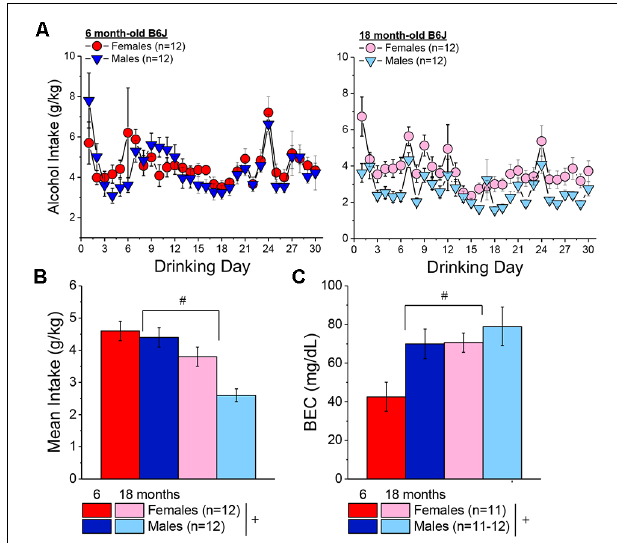
FIGURE 8 | Binge drinking during later maturity (6 months of age) vs. old-age (18 months of age) in isogenic C57BL/6J mice. (A) Comparison of the time-courses of binge drinking between the 6-month-old (left) and 18-month-old (right) mice in Experiment 3. (B) On average, females in Experiment 3 consumed more alcohol than males, and 6-month-old mice consumed more alcohol than 18-month-old mice, over the 30-day course of binge drinking. (C) With the exception of the female 6-month-old mice, the mice in Experiment 3 exhibited BECs within error of the 80 mg/dl criterion for binge drinking. The data represent the means ± SEMs of the number of mice indicated in parentheses in Panel (A) . + p < 0.05 females vs. males; # p < 0.05, 6 vs. 18 months